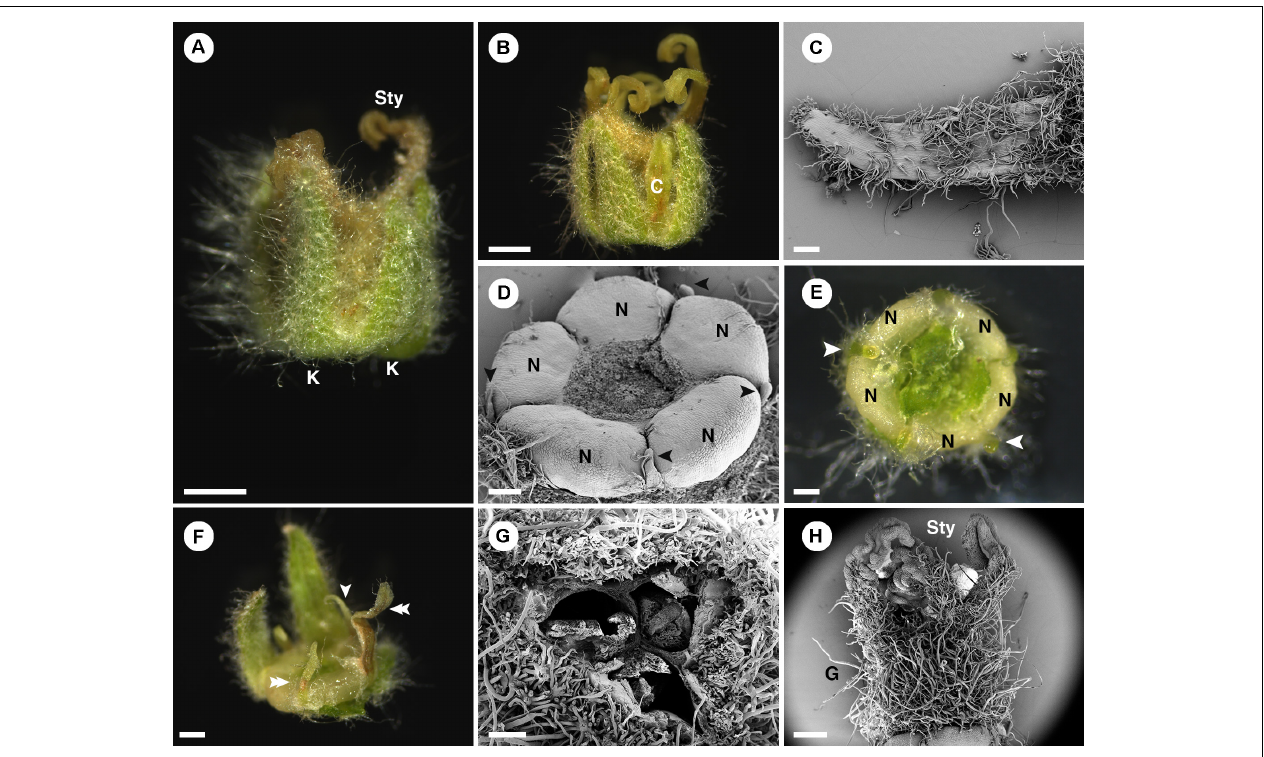
FIGURE 4 | Morphology of pistillate flower of Croton chilensis . (A) A flower at anthesis. Note, sepals are conspicuous while petals are inconspicuous. Note, the abaxial surface of sepals is covered with long stellate trichomes. (B) An anthetic flower with a petal present. (C) Adaxial surface of a sepal covered with variably reduced stellate trichomes. (D) Five nectary glands with small filamentous structures arranged alternately on the outer part. Note, heteromorphy of filamentous structures in the same flower is present with some becoming colleters (arrowhead). (E) Filamentous structures and nectary glands at anthesis. Some filamentous structures become colleters (arrowhead). (F) Variable morphologies of organs alternating with nectaries. Some have a filamentous form (arrowhead), while some resemble petals (double arrowhead). (G) An ovary consisting of three carpels with axile placentation. (H) There are three styles on top of the ovary. The style and stigma have a papillate surface. K, sepal; Sty, style; C, petal; N, nectary; G, ovary. Scale bars: (A,B) = 1,000 µ m; (C–E,G) = 200 µ m; (F,H) = 500 µ m.